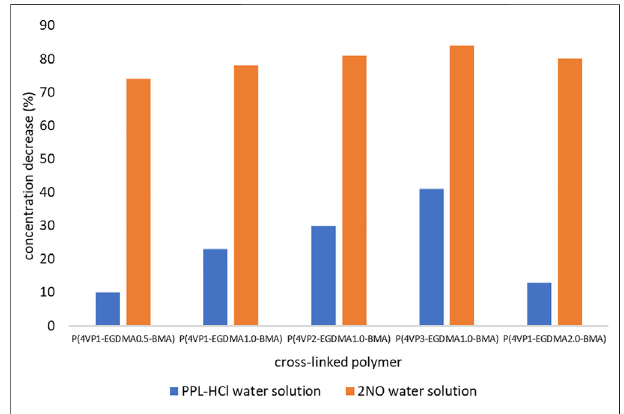
FIGURE 8 | Decreases in concentrations of contaminants following overnight binding experiments (17 h) for crosslinked polymers.